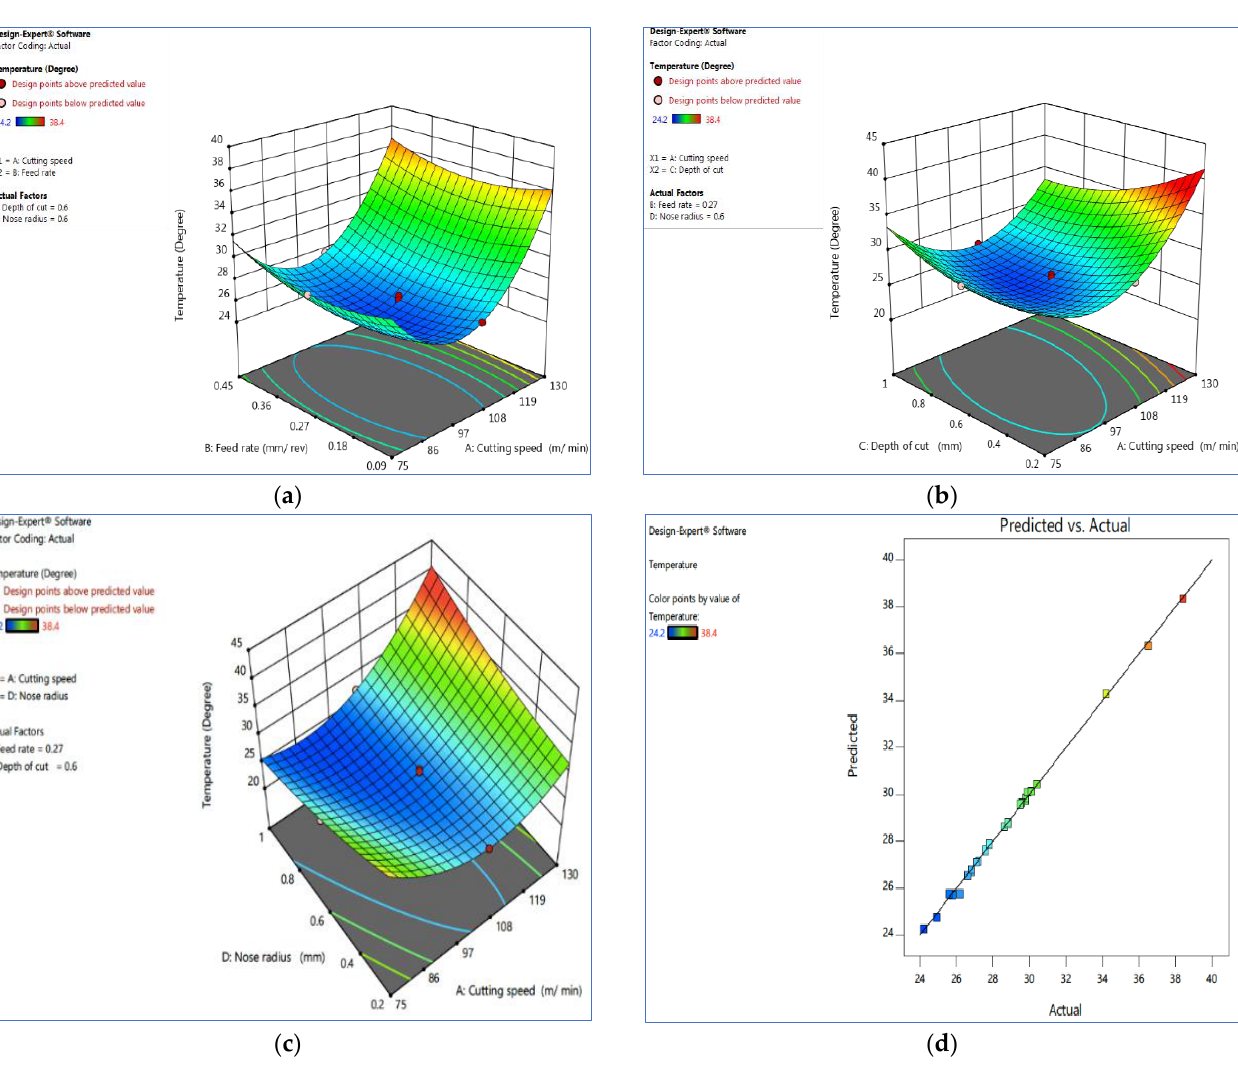
Figure 3. Interaction effect of temperature ( a ) V c vs. F z, ( b ) V c vs. D c , ( c ) V c vs. R n and ( d ) actual vs. predicted plot. Plots produced using Design-Expert software V11 (StatEase, Minneapolis, MN, USA).